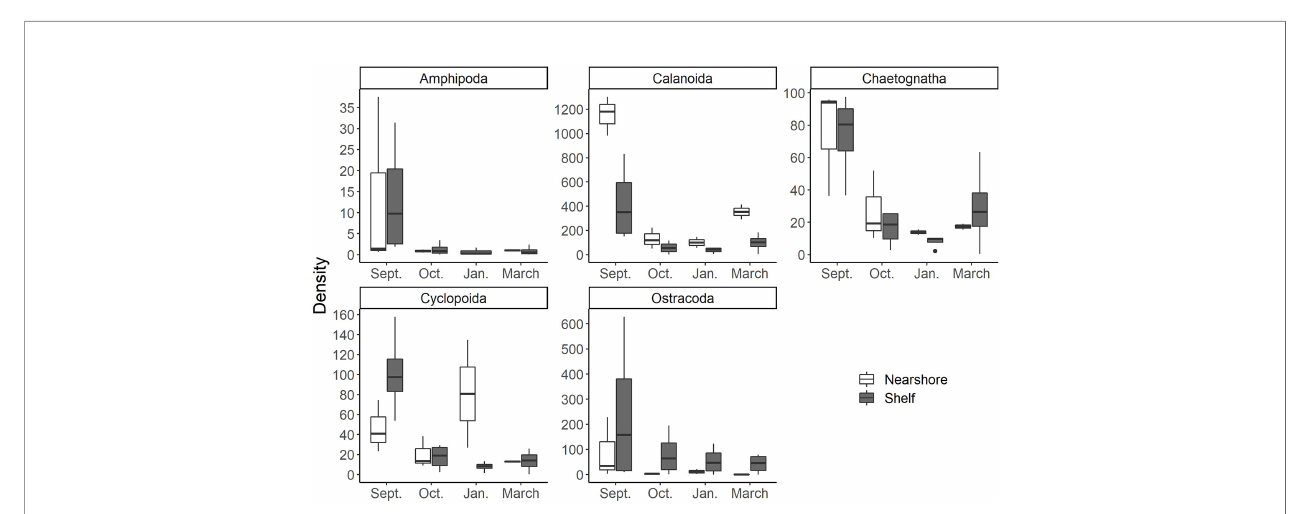
FIGURE 5 | Common mesozooplankton taxa found in larval fi sh gut contents at the study area according to McAskill et al. (in prep). Note differences in scale of the y axis (density; indv m – 3). Nearshore stations are white and shelf stations are